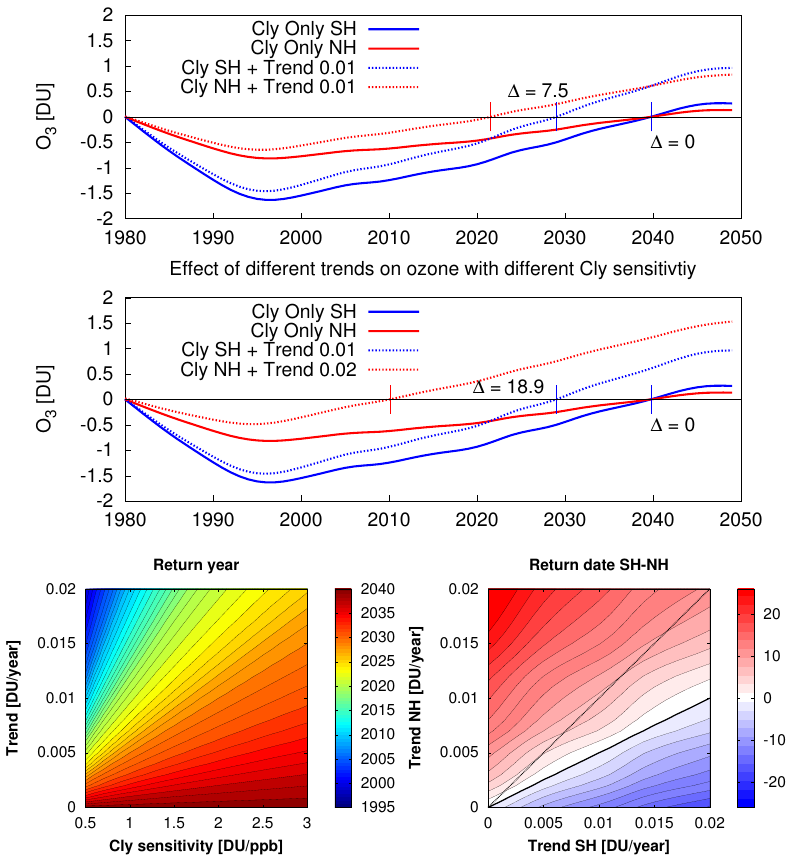
Fig. 5. Schematic of the effect of trends on return dates of ozone to 1980 values. Red and blue lines show ozone time series with different sensitivity to Cl y , representing the NH and SH mid-latitudes. Top: return dates with an identical positive trend in both hemispheres (dotted lines). Middle: return dates with a twice as strong trend in the NH than in the SH. Bottom left: return dates in dependence of the Cl y sensitivity and the trend. Bottom right: differences in return dates of the NH and SH as a function of their trends, assuming a sensitivity of ozone to Cl y of 1DUppb − 1 in the NH and 2DUppb − 1 in the